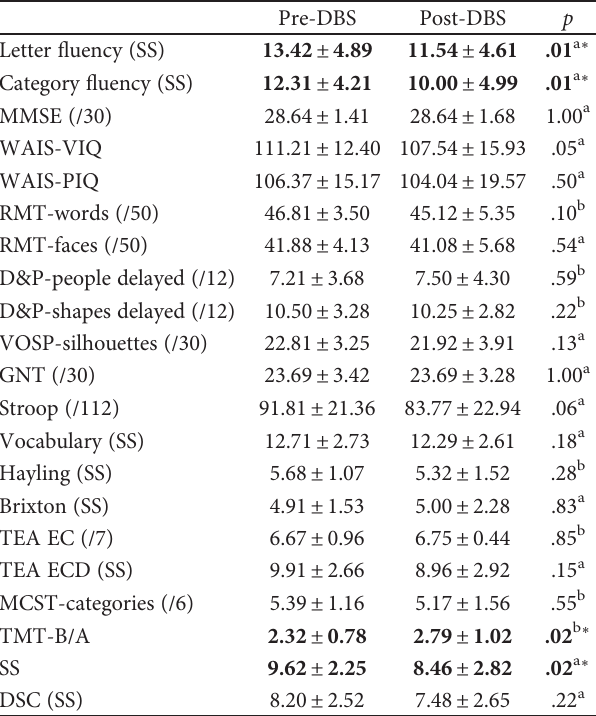
Table 3: Cognitive performance pre- and post-DBS.